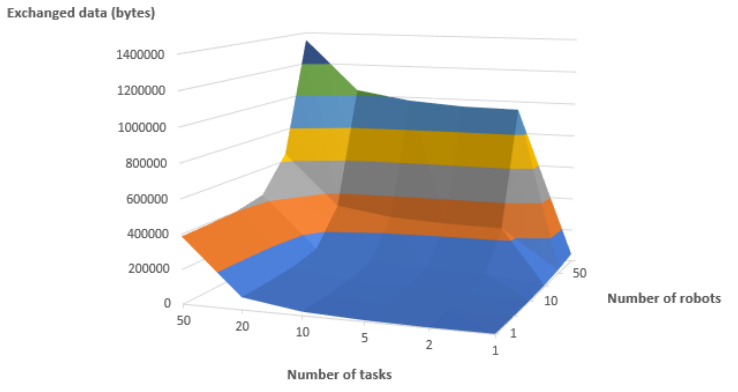
Figure 11. Number of messages according to the number of robots and the number of tasks.